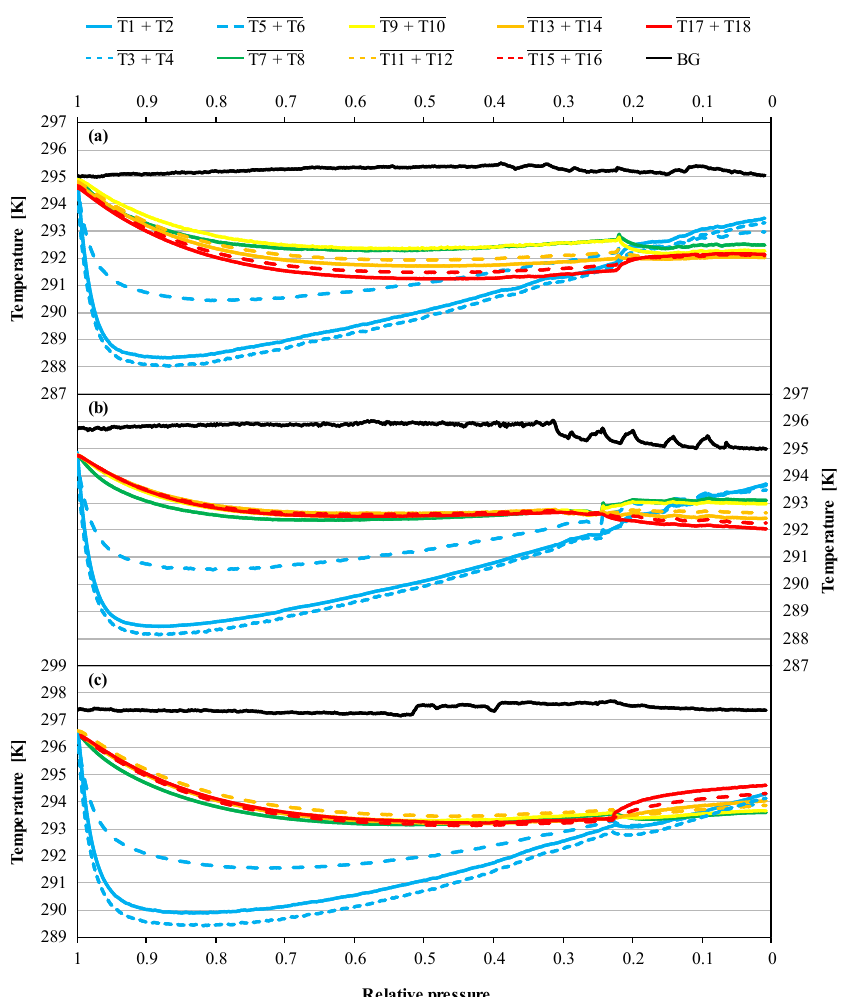
Figure 14. Temperature measurements against relative pressure; note the inverse x axis. Because the initial pressures of the cylinders were slightly different (CB11873 in panel a at 138.4bar, CB11976 in panel b at 128.9 bar and CB11976 in panel c at 133.9bar, respectively), the pressure is expressed as relative pressure ( P/P 0 ) in order to use the same x axes for all three panels. Panel (a) shows the temperature measurements of a high-flow experiment, where a vertically positioned cylinder was laid down (CB11873 at 32.1bar); panel (b) shows a high-flow experiment, where a horizontally positioned cylinder was put up (CB11976 at 32.7bar); and panel (c) shows the temperature of a cylinder that was horizontally positioned and then put upside down (CB11976 at 32.2bar). The lines represent averages of the following thermistors. Pressure regulator to stem: solid blue, T1 and T2; dotted blue, T3 and T4; dashed blue, T5 and T6. Cylinder valve: green, T7 and T8. Cylinder body: yellow, T9 and T10; dashed orange, T11 and T12; solid orange, T13 and T14; dashed red, T15 and T16; solid red, T17 and T18. Laboratory background: black, T19 to